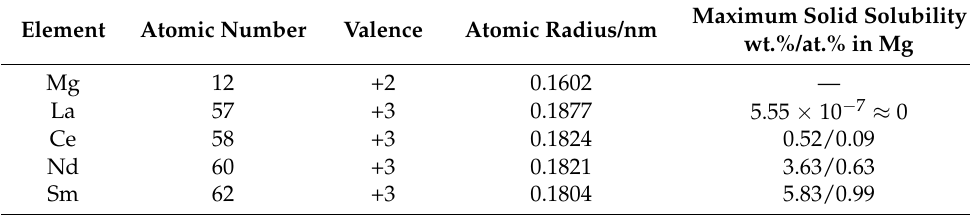
Table 2. Atomic number, valence, atomic radius and maximum solid solubility in the Mg solid solution of the four solute